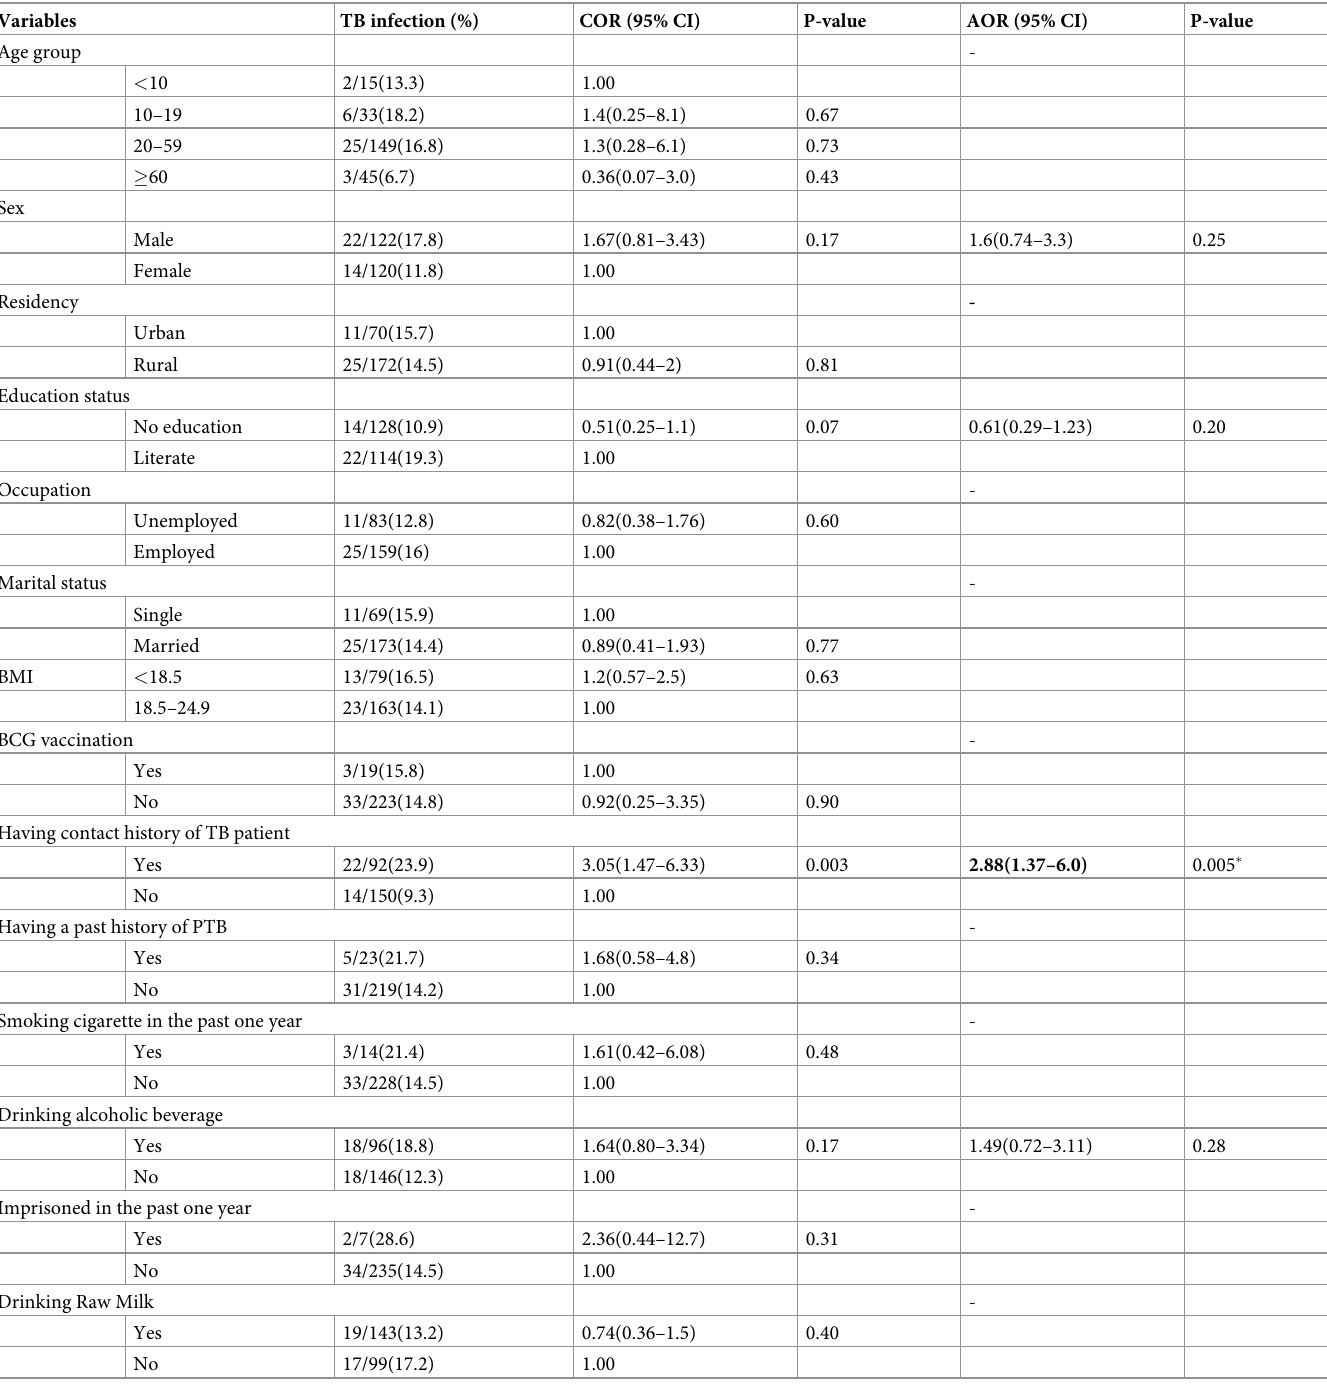
Table 5. Multivariate analysis for PTB among PTB suspected patients attending Kuyu General Hospital, North Shewa, Oromia, Ethiopia, 2020(n =